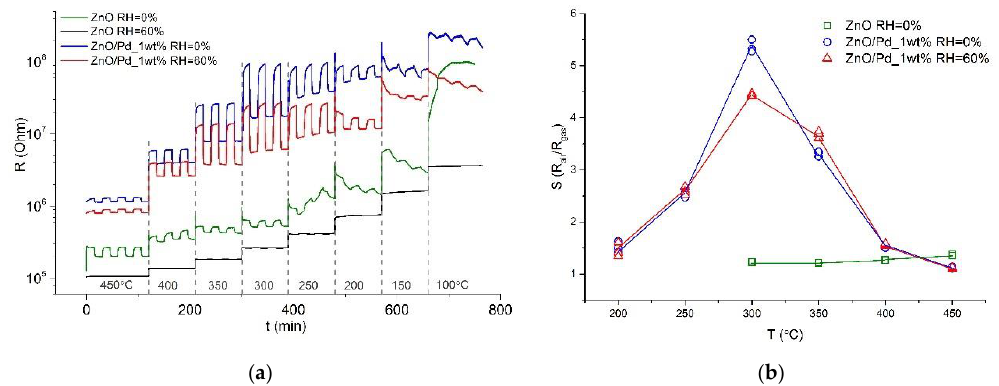
Figure 6. Transient sensor response ( a ) and temperature dependence of sensor signal ( b ) of ZnO and ZnO/Pd nanofibers to 5 ppm CO in dry (RH 25 = 0%) and humid (RH 25 = 60%).